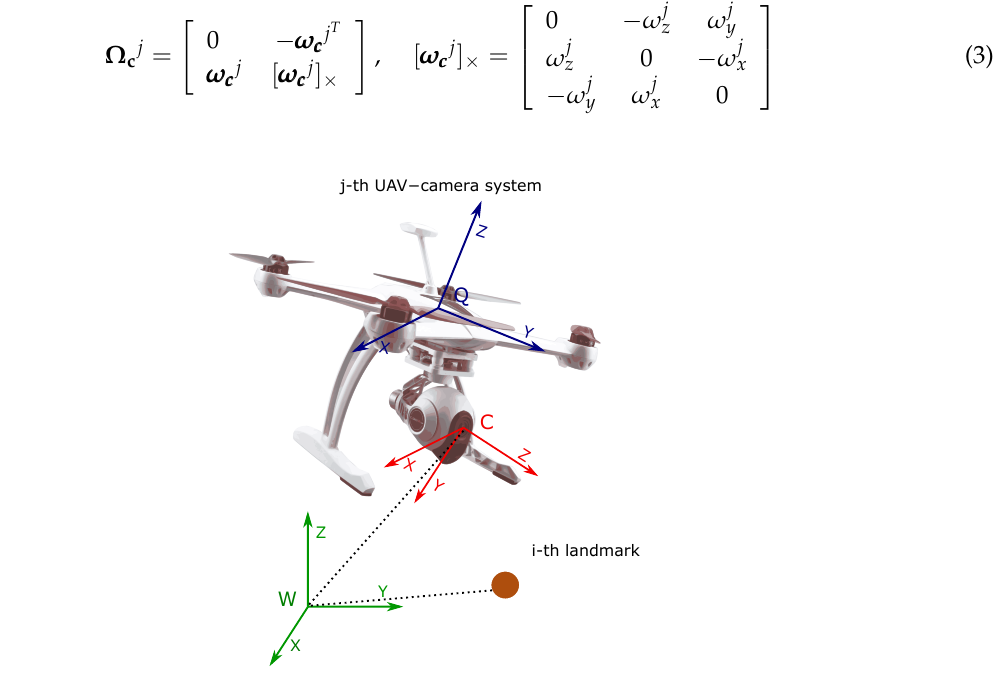
Figure 2. Coordinate reference